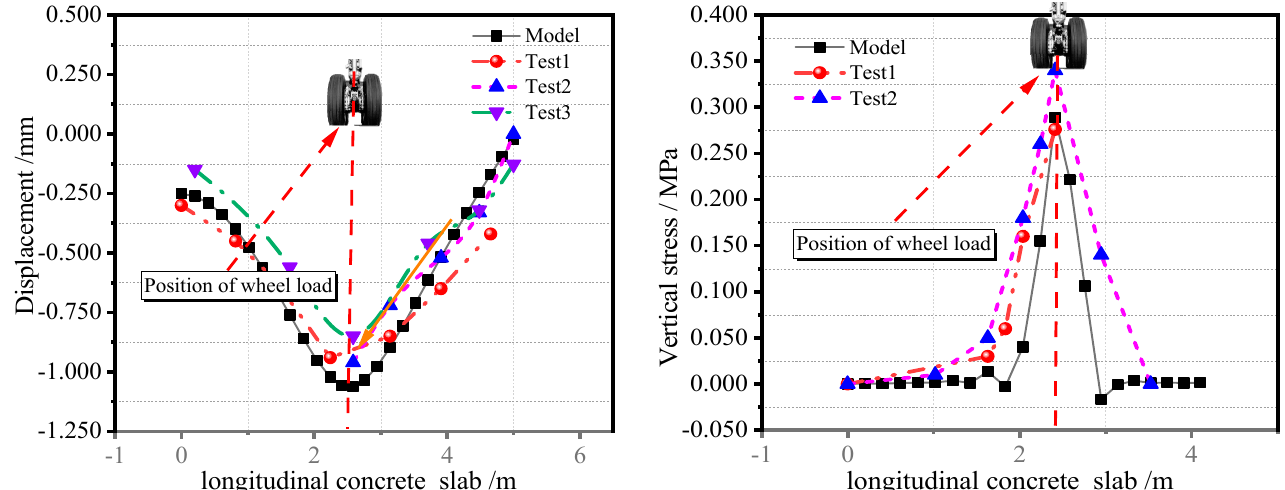
Figure 14. Comparison between the laboratory test and simulation results [49–52].